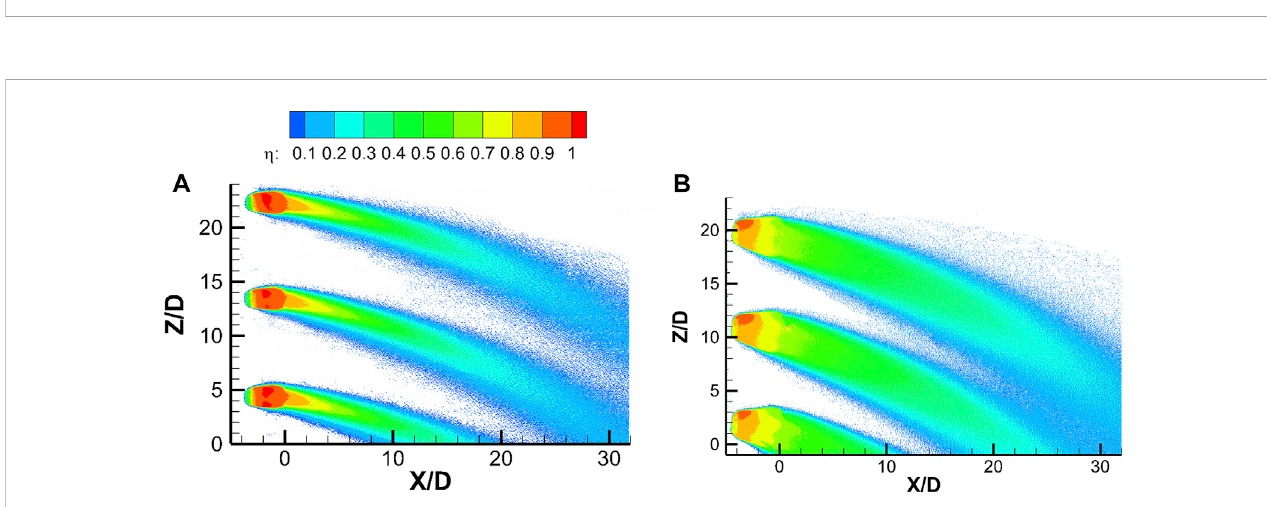
Frontiers in Mechanical